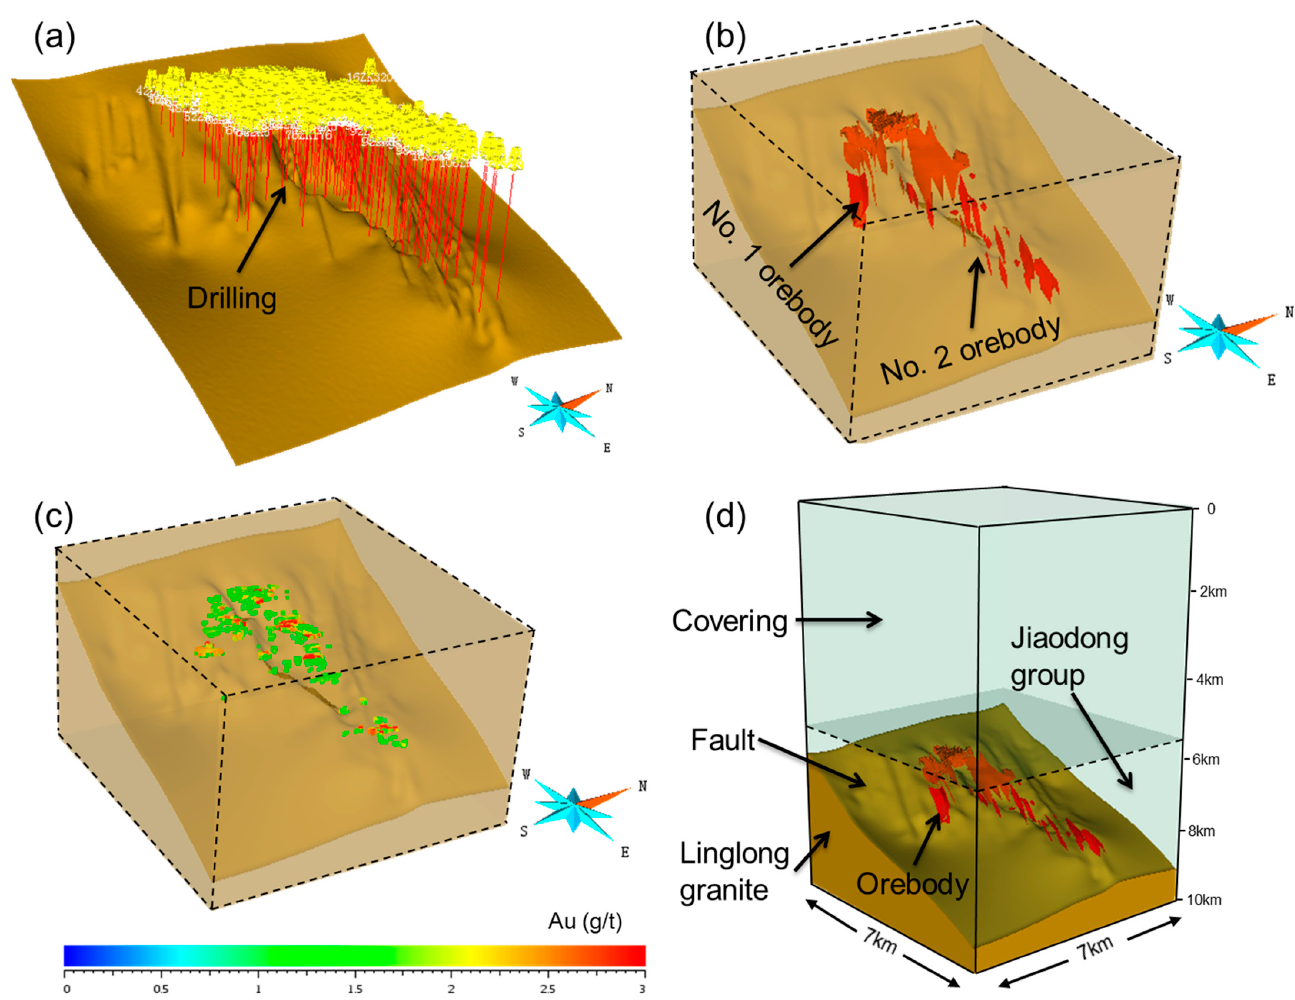
Figure 5. ( a ) 3D models of the fault and drill holes; ( b ) 3D models of fault and orebody; ( c ) gold grade distribution; ( d ) numerical simulation